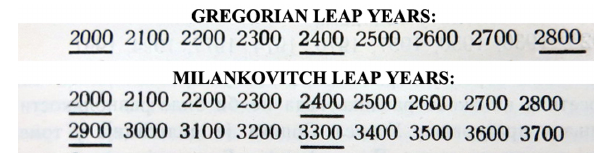
Figure 5. Centennials or secular years with underlined leap